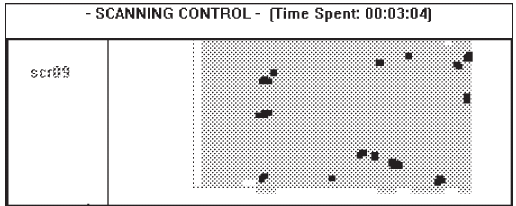
Fig. 6. False negative slide. Abnormal cells shown as black